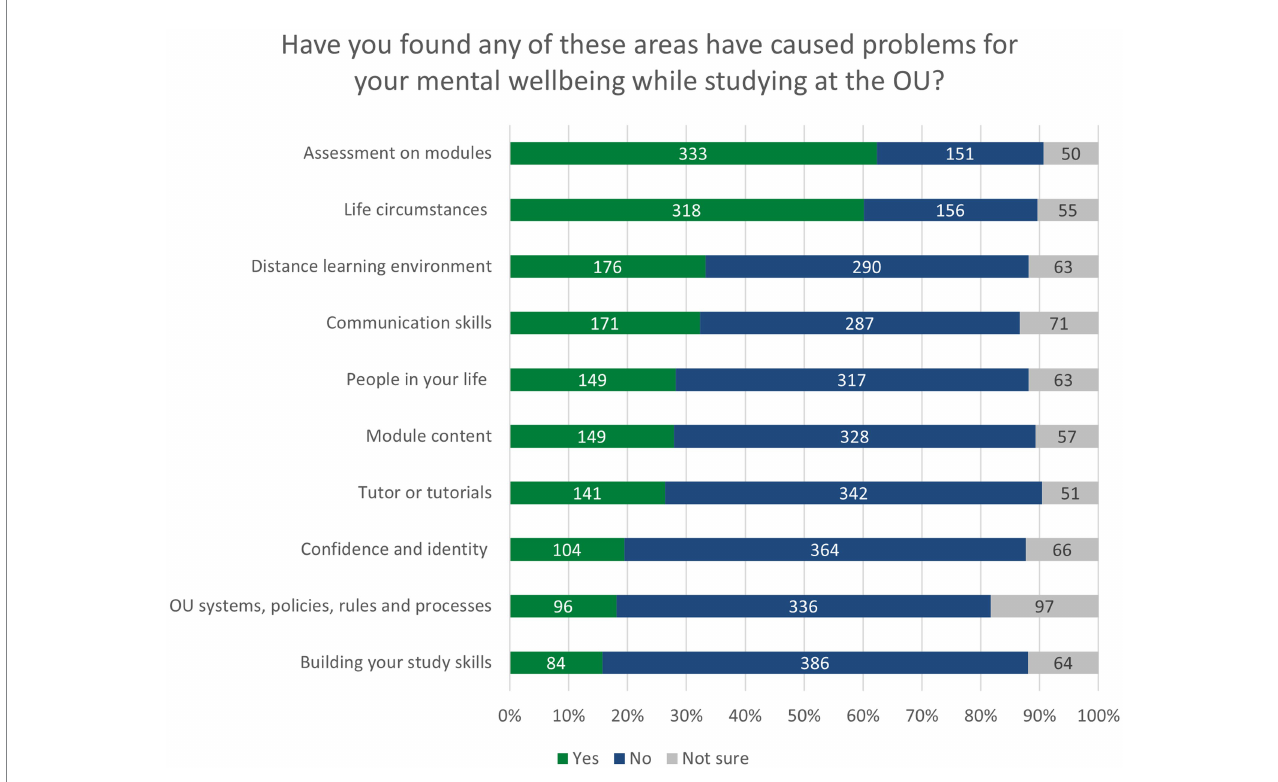
FIGURE 1 Taxonomy of barriers and enablers to mental wellbeing in distance learning (Lister et al.,